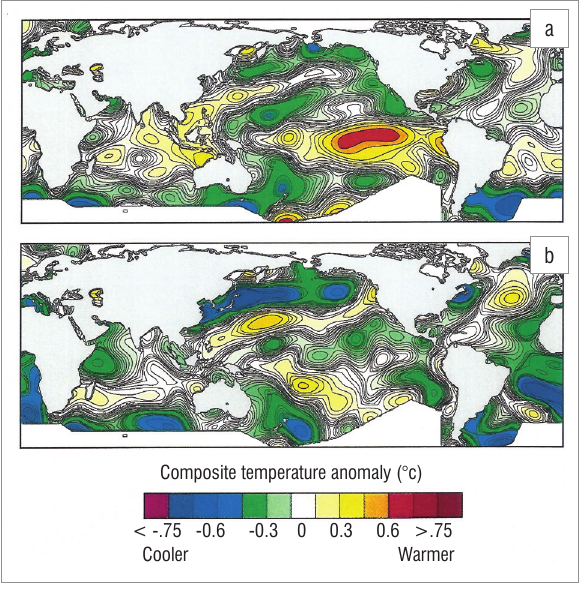
Figure 4: Composite sea-surface temperature anomalies for the (a) 10 driest and (b) 10 wettest years in the reconstructed rainfall record shown in Figure 6.